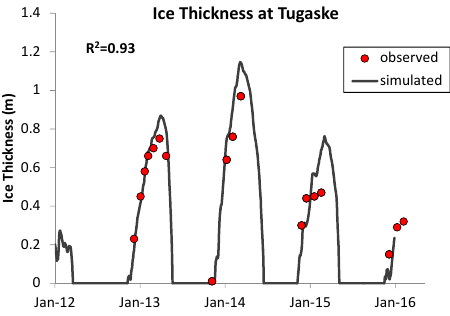
Figure 5. Daily simulated ice thickness at the Tugaske Bridge.